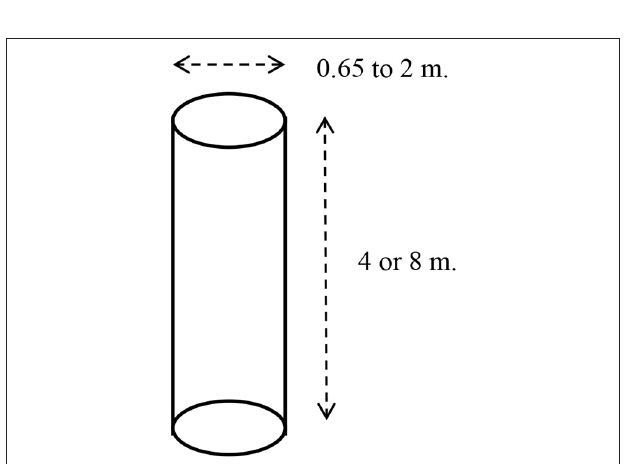
FIGURE 3 | Lateral view of a longitudinal axis of the bridge.